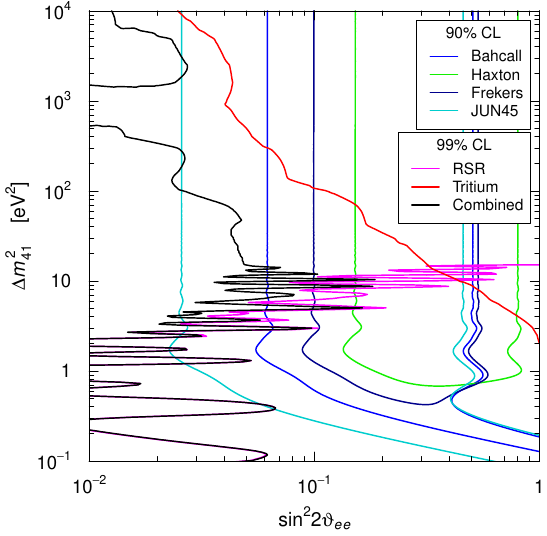
Figure 7 . Comparison of the regions in the (sin 2 2 # ee ; (cid:1) m 2 ) plane allowed at 90% CL by the 41 gallium neutrino anomaly using the Bahcall [49], Haxton [50], Frekers [51], and JUN45 [52] neu- trino detection cross sections discussed in ref. [52] with the 99% CL exclusion curves obtained from the combined analysis of the data of the Mainz, Troitsk and KATRIN tritium experiments and the combined analysis of the reactor spectral ratio (RSR) measurements of the Bugey-3, NEOS, PROSPECT and DANSS experiments. Also shown is the combined tritium and reactor exclu- sion